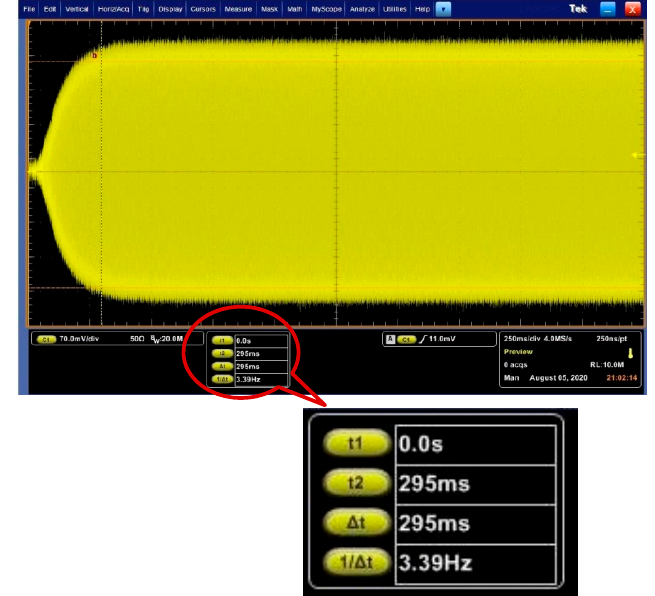
Figure 17. Start ‐ up waveform of PLL loop with DRG experimental board. Figure 17. Start-up waveform of PLL loop with DRG experimental